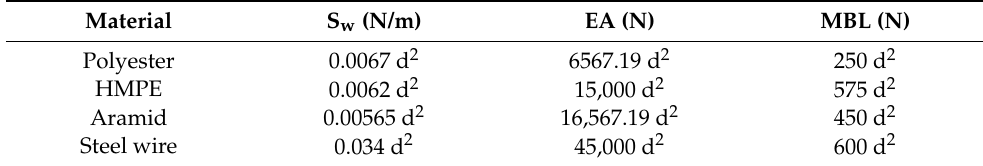
Table 4. Properties of mooring lines used in the study [50].